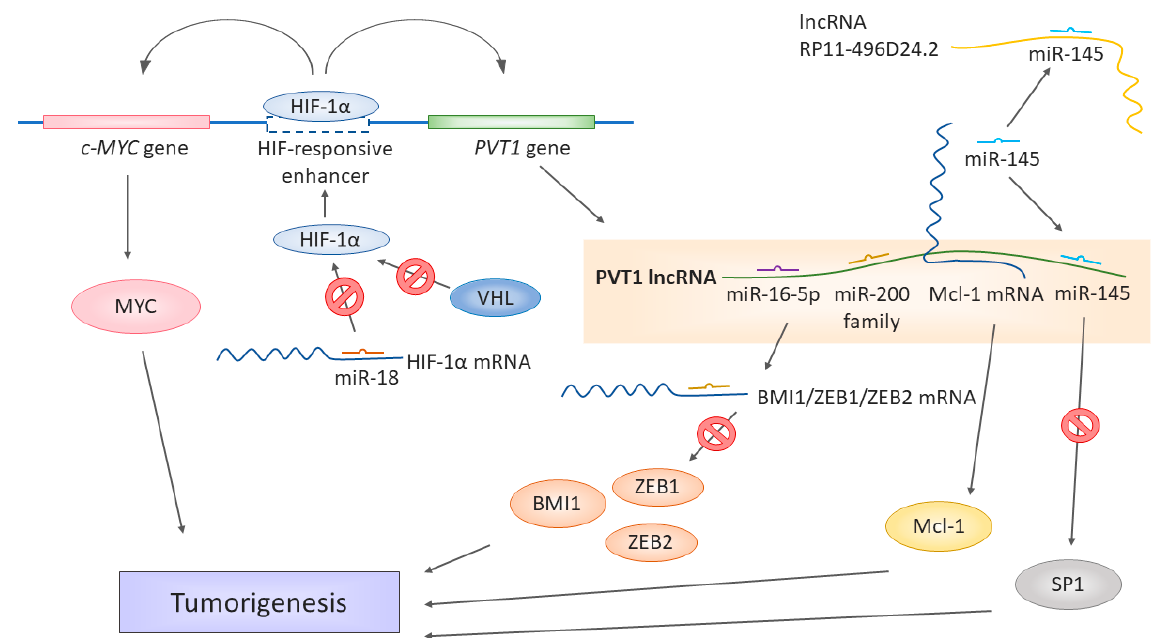
Figure 1. Different ways of lncRNA PVT1 contributing to the development of renal cell carcinoma. miR-18 binds to HIF-1 α mRNA and prevents it from translation. If downregulated, the miR-18 levels are not sufficient to keep the expression of HIF-1 α in check. However, while the normal oxygen levels last, protein HIF-1 α is targeted by VHL for degradation. In hypoxia, HIF-1 α is stabilized and cannot be targeted by VHL and can be transferred to the nucleus. The PVT1 gene is under the HIF-responsive enhancer, along with cMYC . HIF-1 α binding to this enhancer activates the expression of both c-MYC and PVT1 . PVT1 itself serves as a miRNA sponge binding the miR-16-5p, miR-145, and miR-200 family members, thus liberating the target mRNA from miRNA-induced degradation, for example, BMI1, ZEB1, ZEB2 , and SP1 . miR-145 is a target of both PVT1 and RP11-496D24.2 in the ceRNA network. Moreover, PVT1 stabilizes larger mRNA molecules such as Mcl-1 , which, in turn, can be translated into functional Mcl-1 proteins. The upregulation of PVT1 is thus associated or directly responsible for the upregulation of significant factors promoting tumorigeneses, such as MYC, Mcl-1, BMI1, ZEB1, ZEB2, and